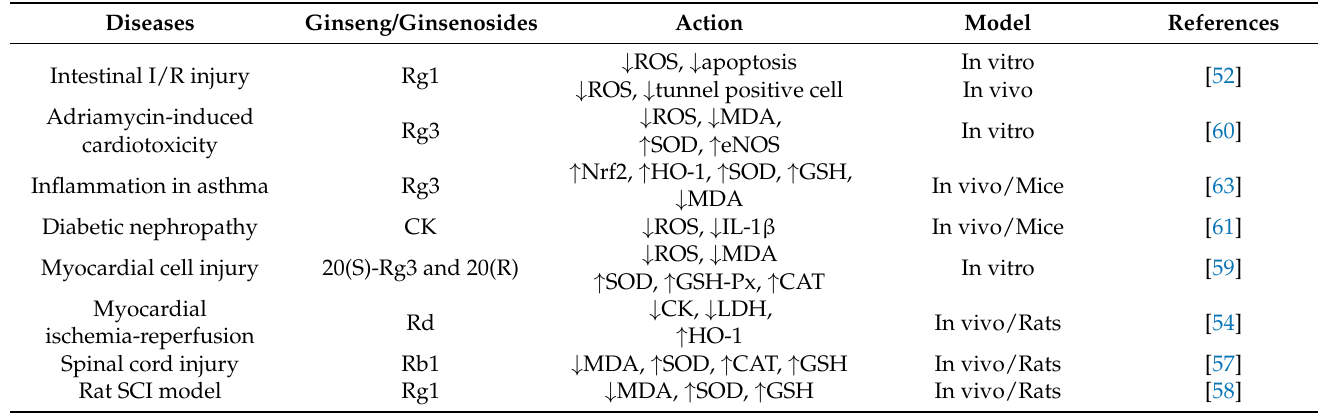
Table 1. Antioxidant activity of ginseng/ginsenosides in oxidative-stress-mediated diseases.